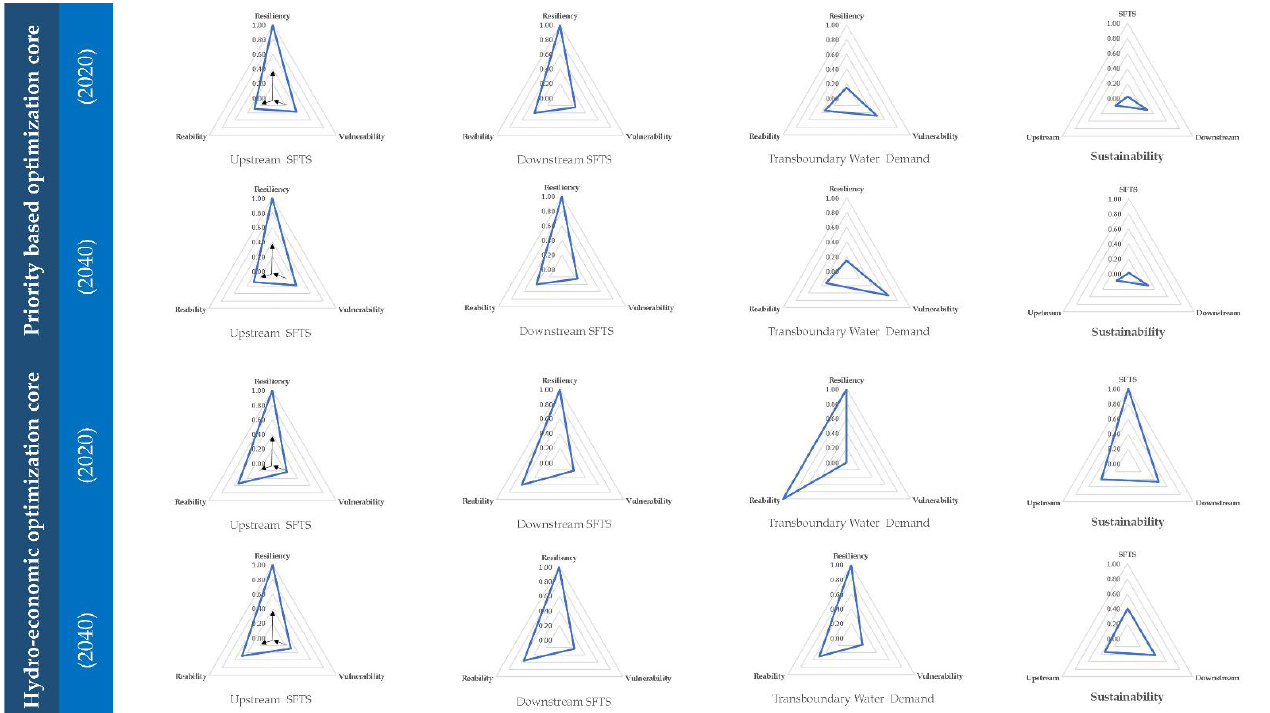
Figure 10. Sustainability indicators based on the results of applying the AcquaNetGIS model (an alternative representation of the revenue curves is presented in the Supplementary Material).